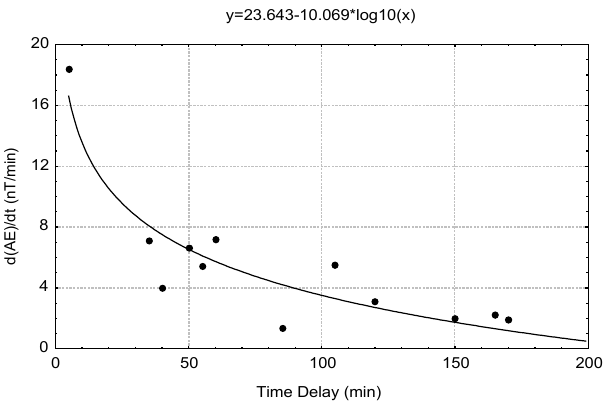
Fig. 10. The rate of AE index increase, estimated for 12 clear cases of nighttime height enhancements, as a function of the time delay in height enhancements observation with reference to the onset of an energy dissipation episode.